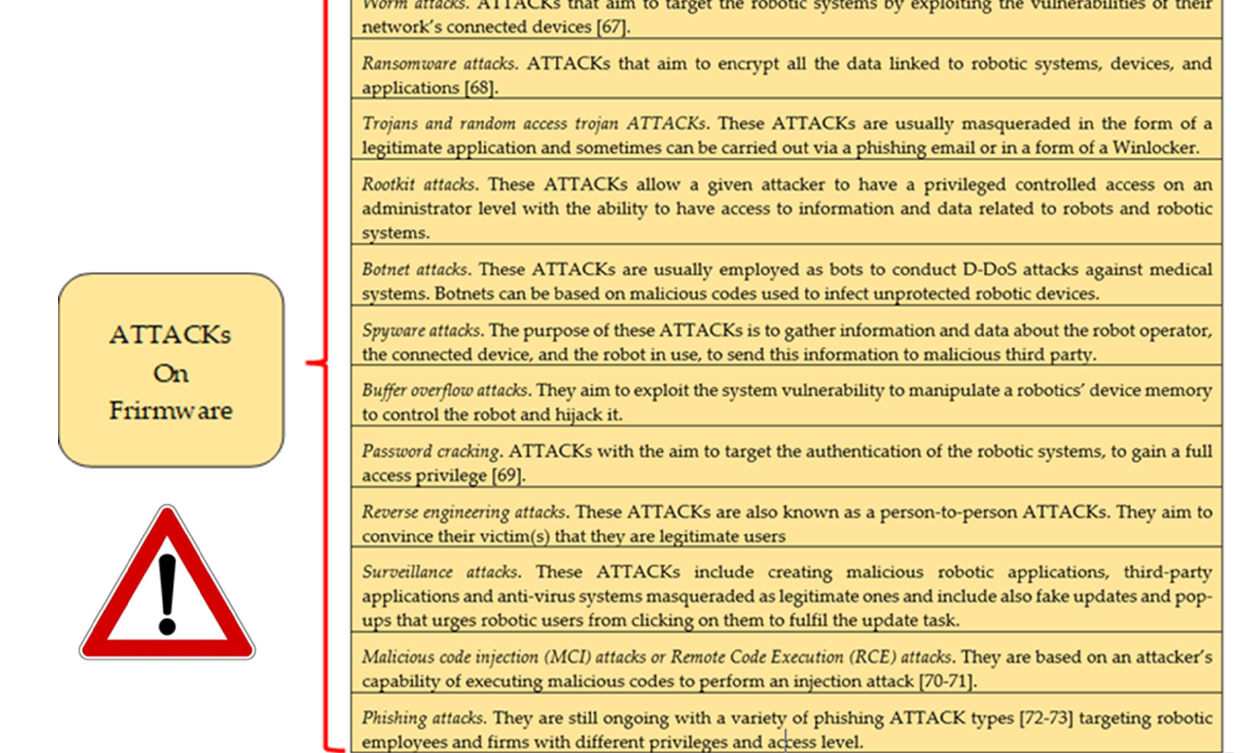
Figure 3. Examples of ATTACKs on the firmware.